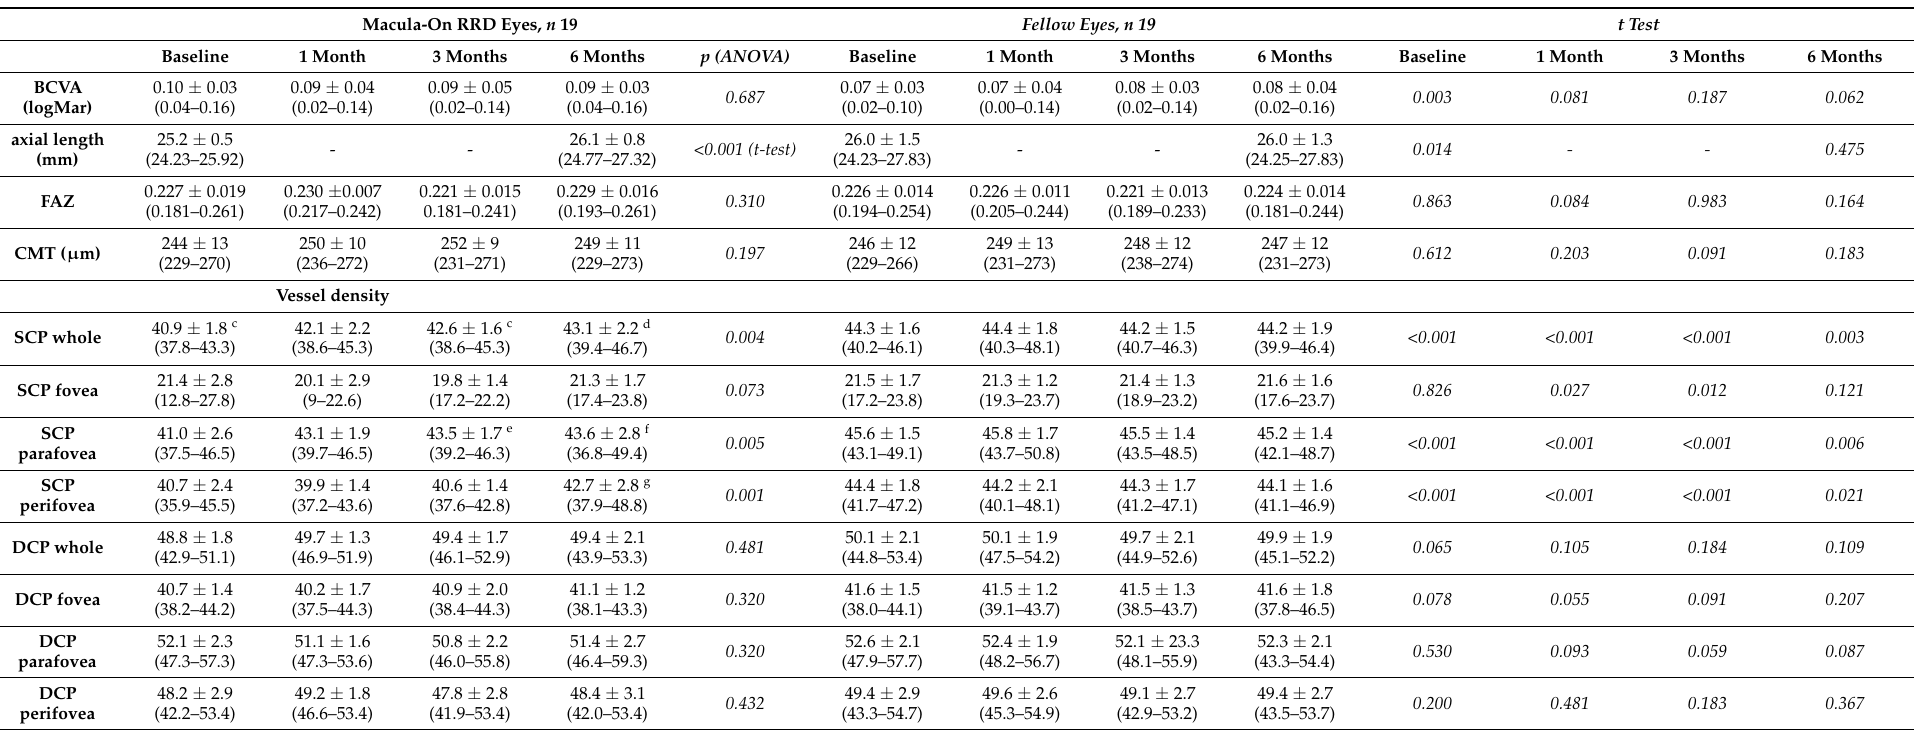
Table 2. Clinical and OCTA parameters of the macula-on RRD